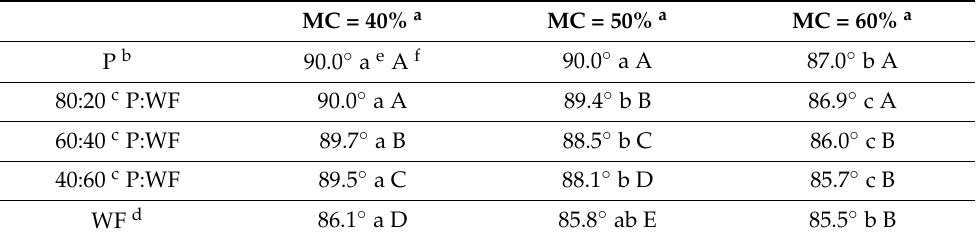
Table 2. Contact angles ( ◦ ) measured on substrates prepared at 40%, 50% and 60% Moisture Contents, (90 ◦ = no capillary